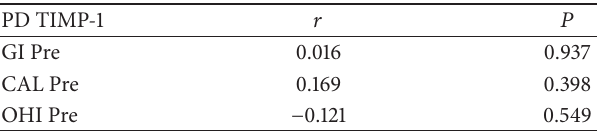
Table 3: Correlation of periodontally diseased TIMP-1 levels with clinical parameters namely gingival index, clinical attachment level, and oral hygiene index before nonsurgical periodontal therapy.